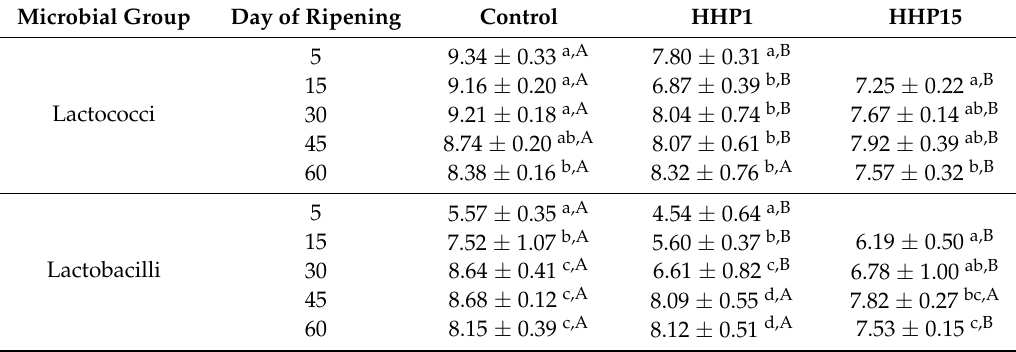
Table 2. Changes in microbial population (mean values ± standard deviation as log 10 CFU/g) of the ewes’ raw milk cheese samples with and without HHP treatment during